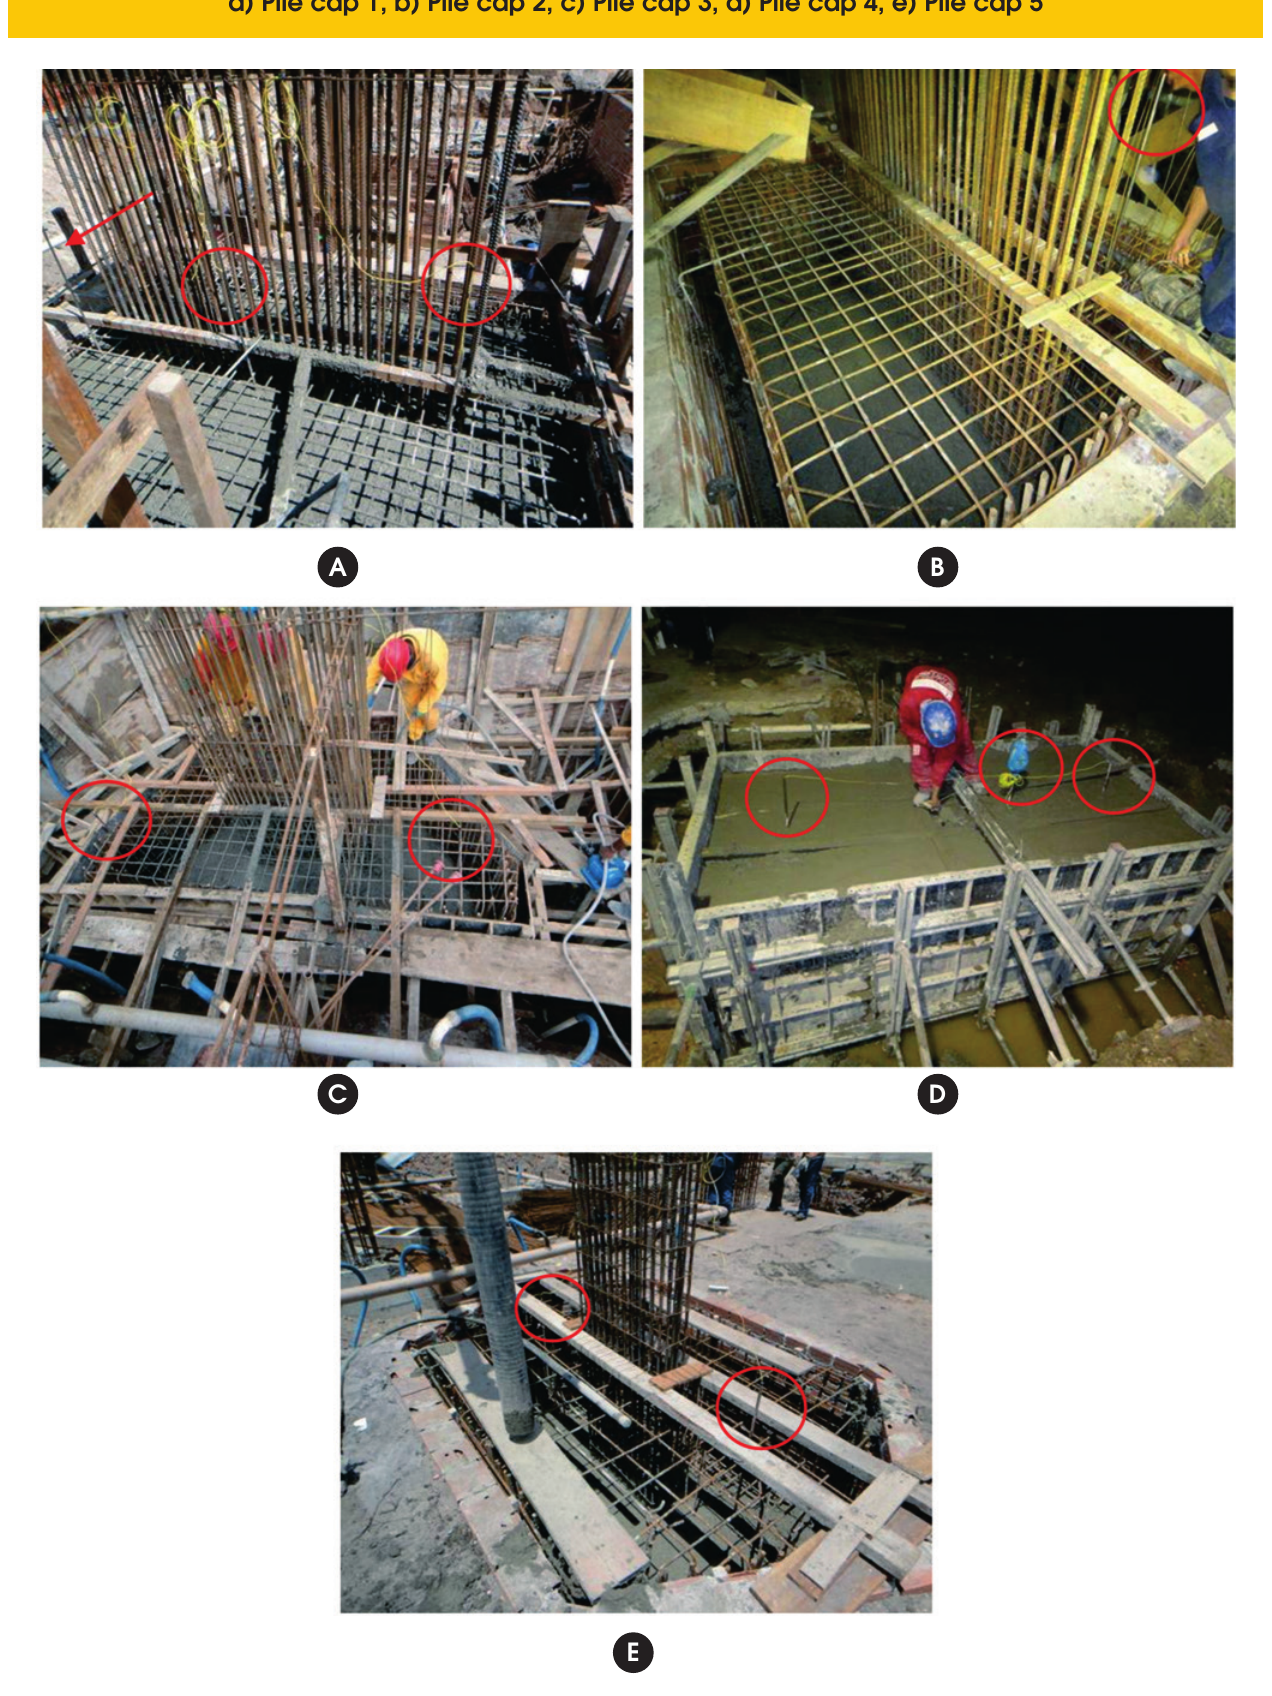
Figure 4 – Real details of the geomety of the pile caps and allocation of the